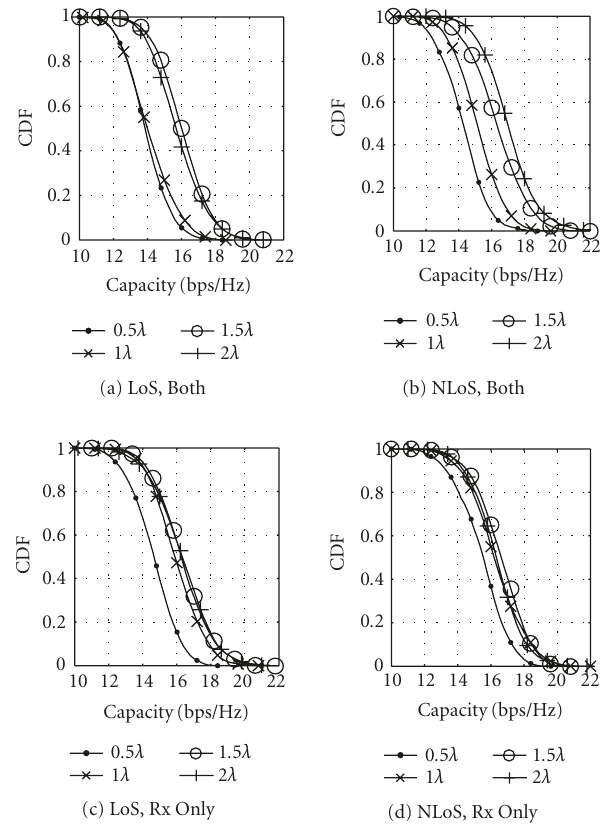
Figure 9: Theoretical 4 4 MIMO-OFDM channel capacity (SNR (cid:0) = 15 dB) for di ff erent antenna